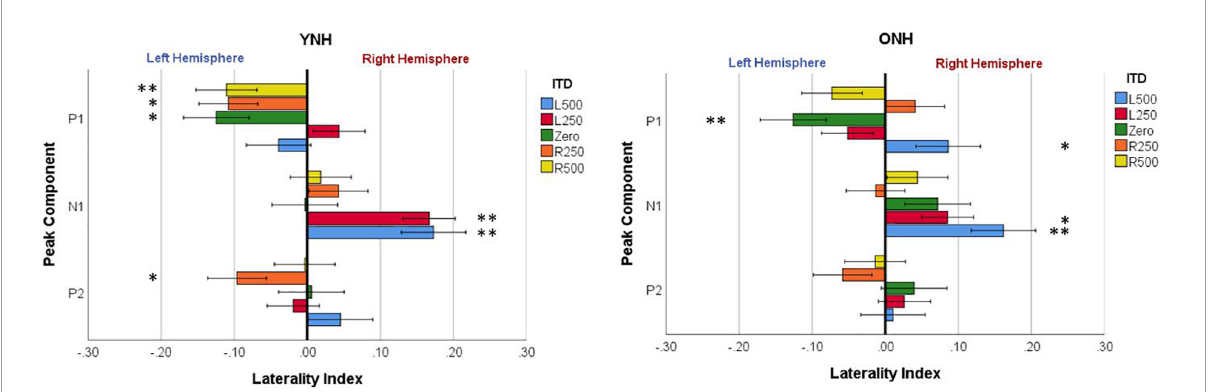
FIGURE8 Mean laterality index for each interaural time difference (ITD) condition plotted relative to latency of peak components (P1, N1, P2) for YNH (left panel) and ONH (right panel) groups. Significant effect of peak component on laterality plotted relative to ITD condition is indicated for the following p -values: ∗ p < 0.05, ∗∗ p < 0.01 .